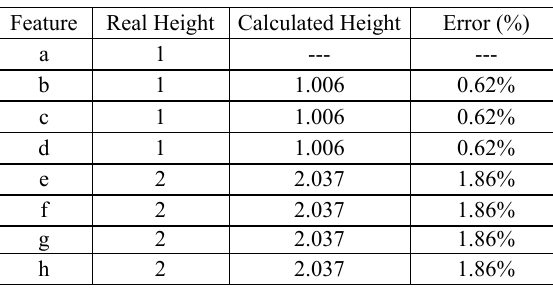
Table 1: Validations in elevation of cylinder shape computer simulated geometric structure case.